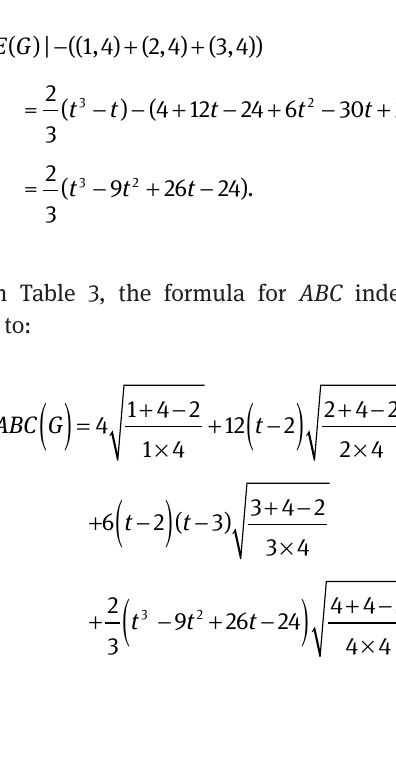
Table 3: The quantity of ( m , n )-type edges of tetrahedral